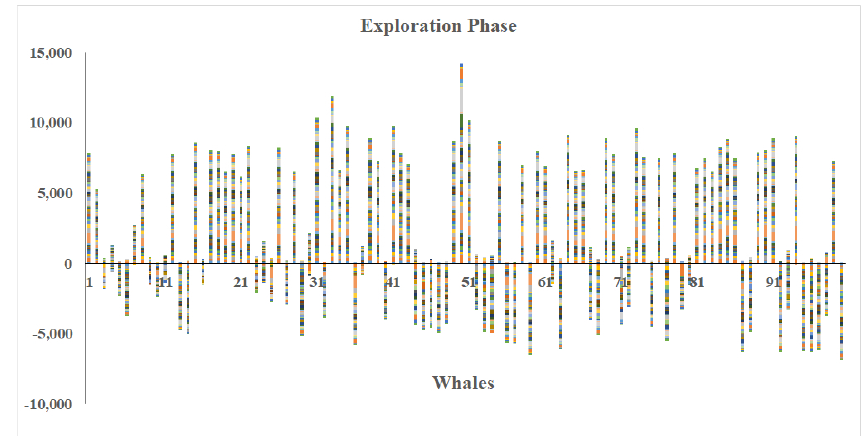
Figure 7. Exploration phase of the proposed EVWOA.